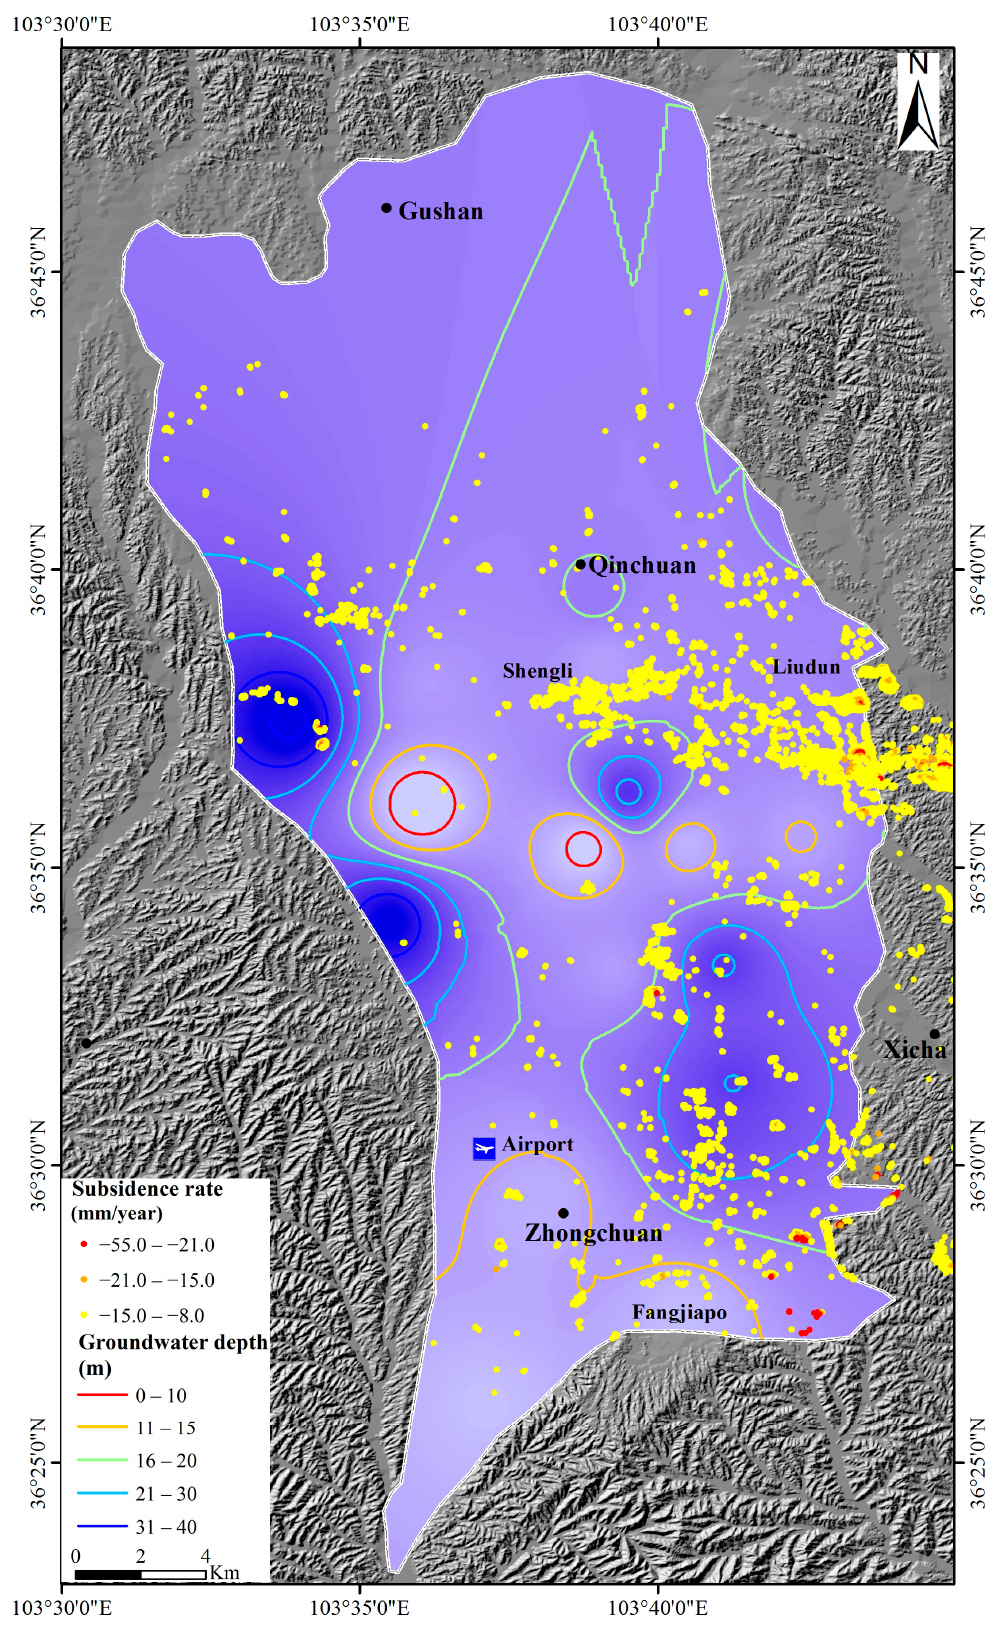
Figure 13. Distribution of land subsidence rate and groundwater contour map in LZND.